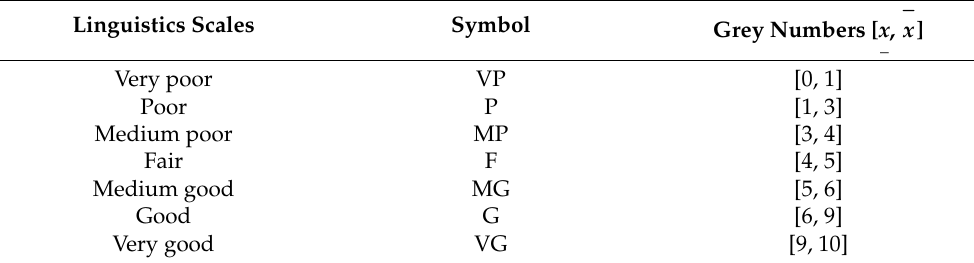
Table 3. The linguistics scales with grey numbers in the